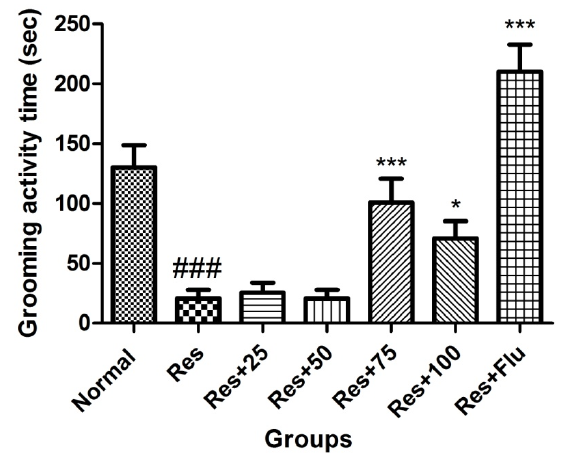
Figure 3. The effect of intraperitoneal injection of four different concentrations of Kelussia odoratissima Mozaffarian extract (25, 50, 75 and 100 mg/kg) on the licking time of mice. Flu= Fluoxetine, Res=reserpine. # Vs. normal group ( ### P < 0.001 * Vs. reserpine- receiving group ( * P < 0.05, *** P <